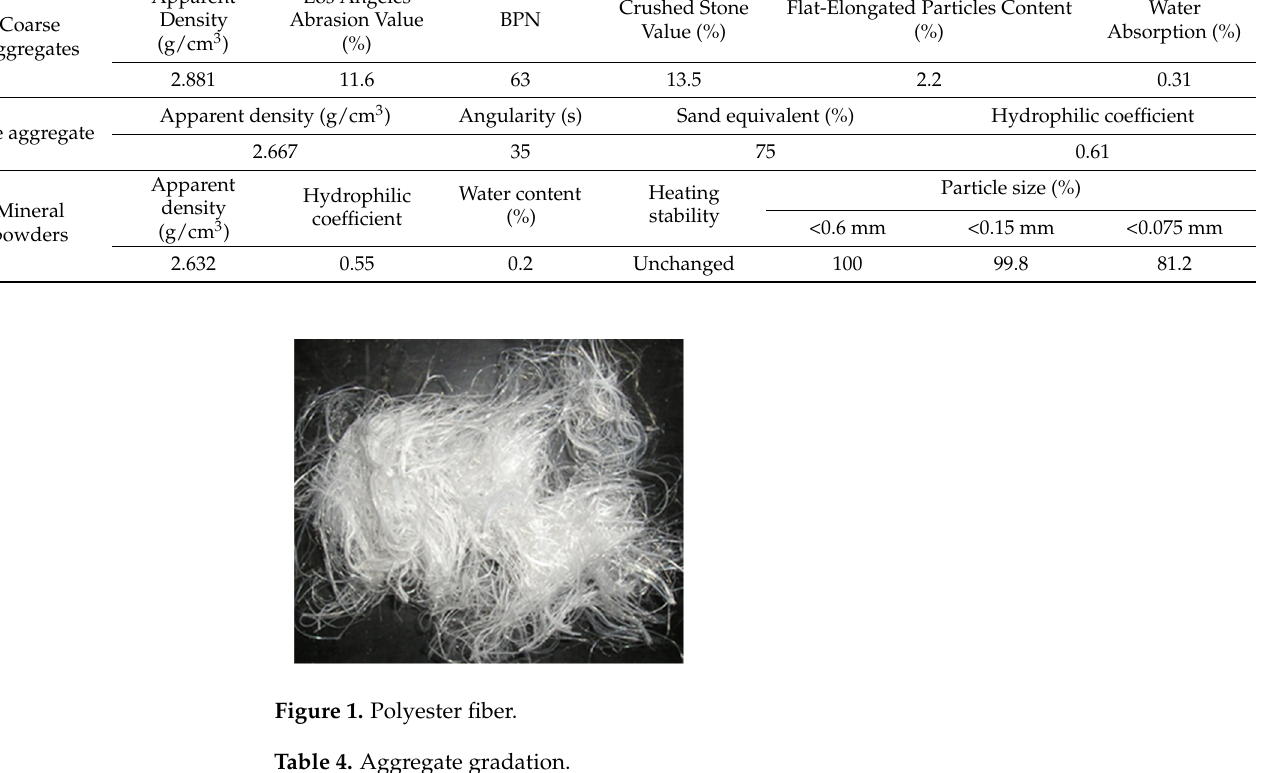
Table 3. Technical parameters of aggregates.